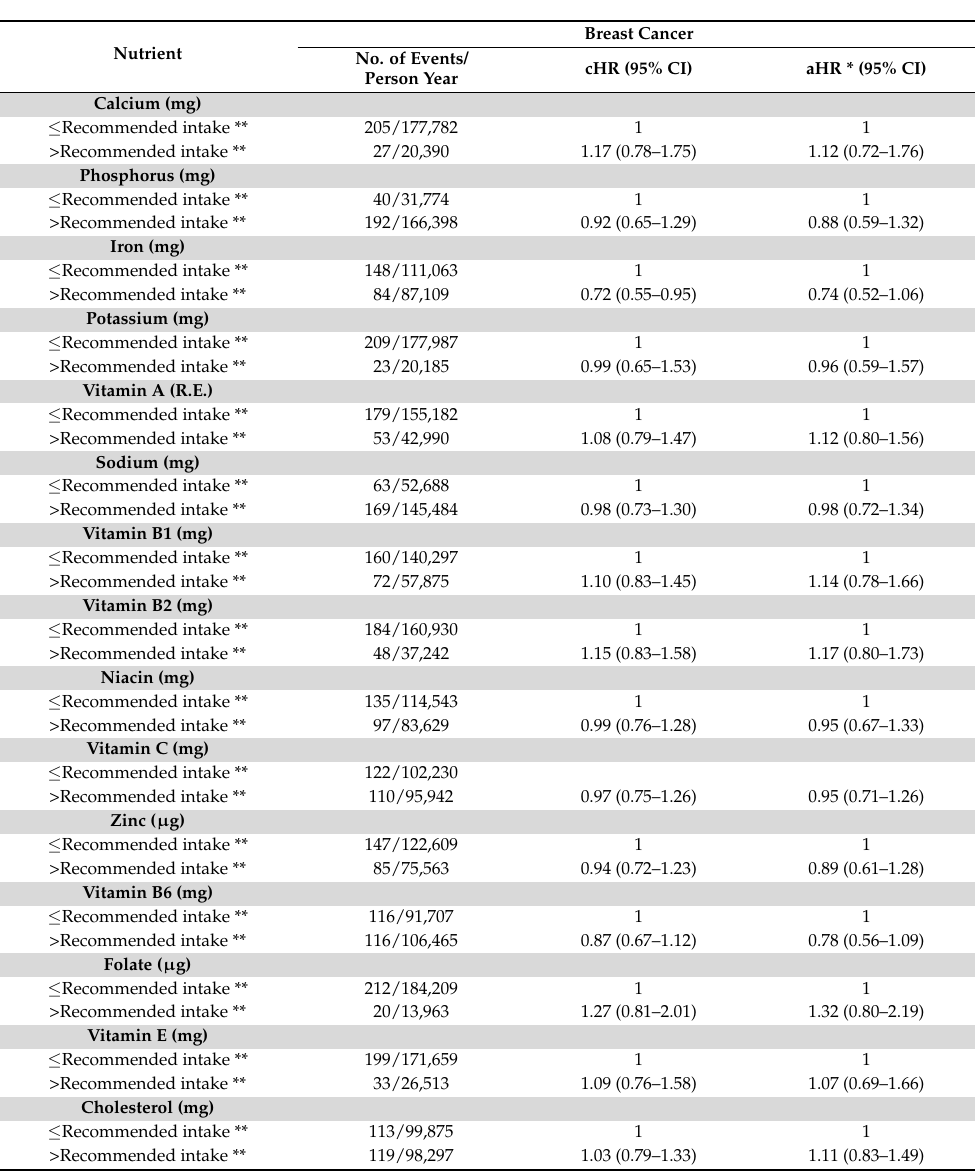
Table 3. HR (95% CI) of breast cancer risk for recommended nutrient